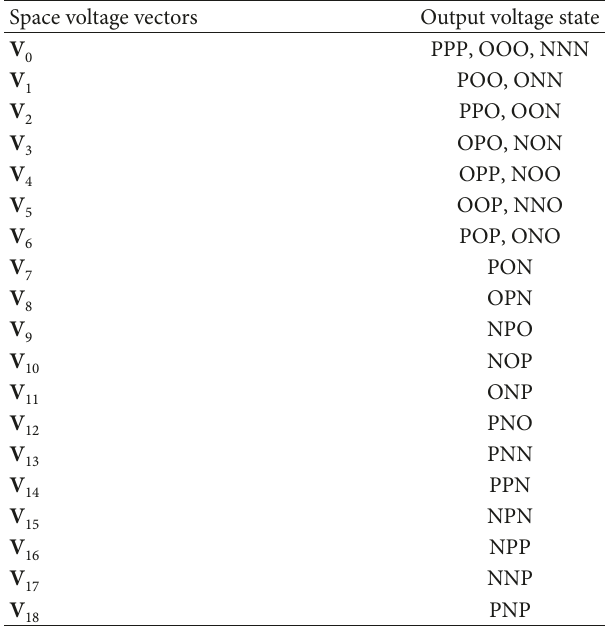
Table 1: Space voltage sectors and corresponding output voltage states.